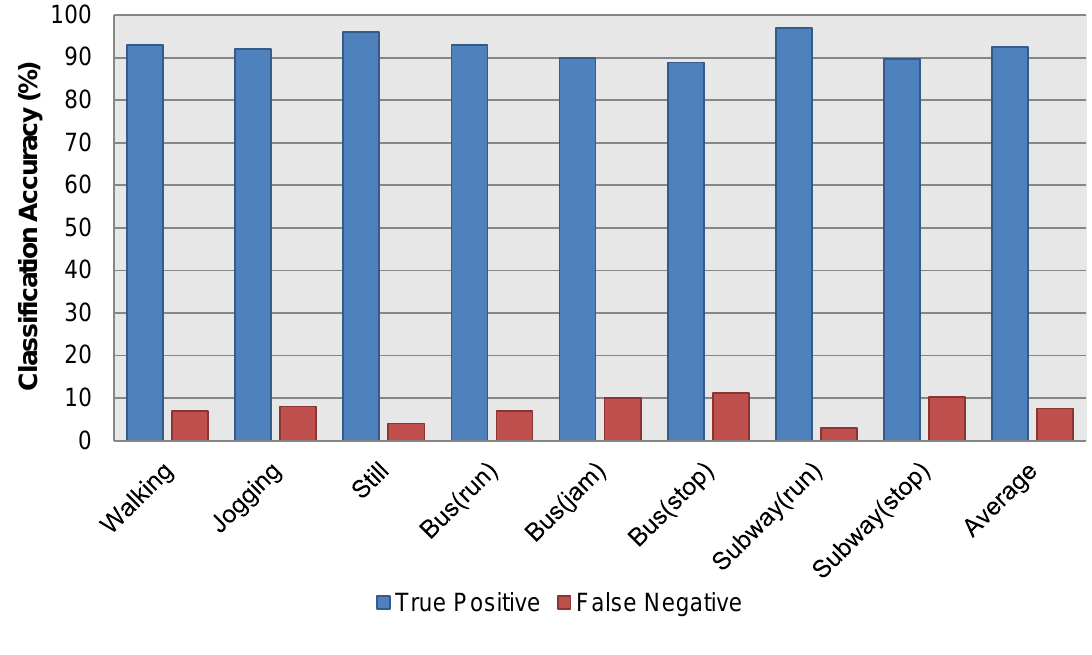
Figure 5. Classification accuracy of the integrated system based on Table